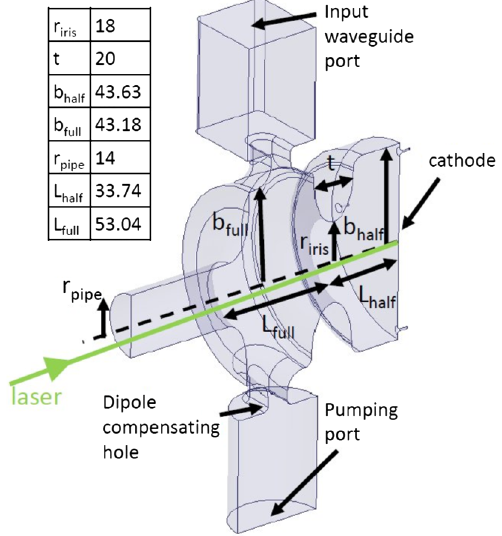
FIG. 1. Geometry of the gun with the main